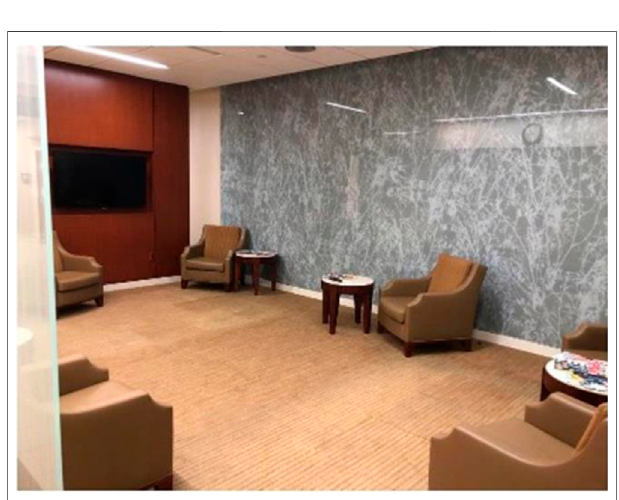
FIGURE9| Waitingarea:HospitalinCarmel,Indiana(2019),photograph by Lisann Good-Burton.